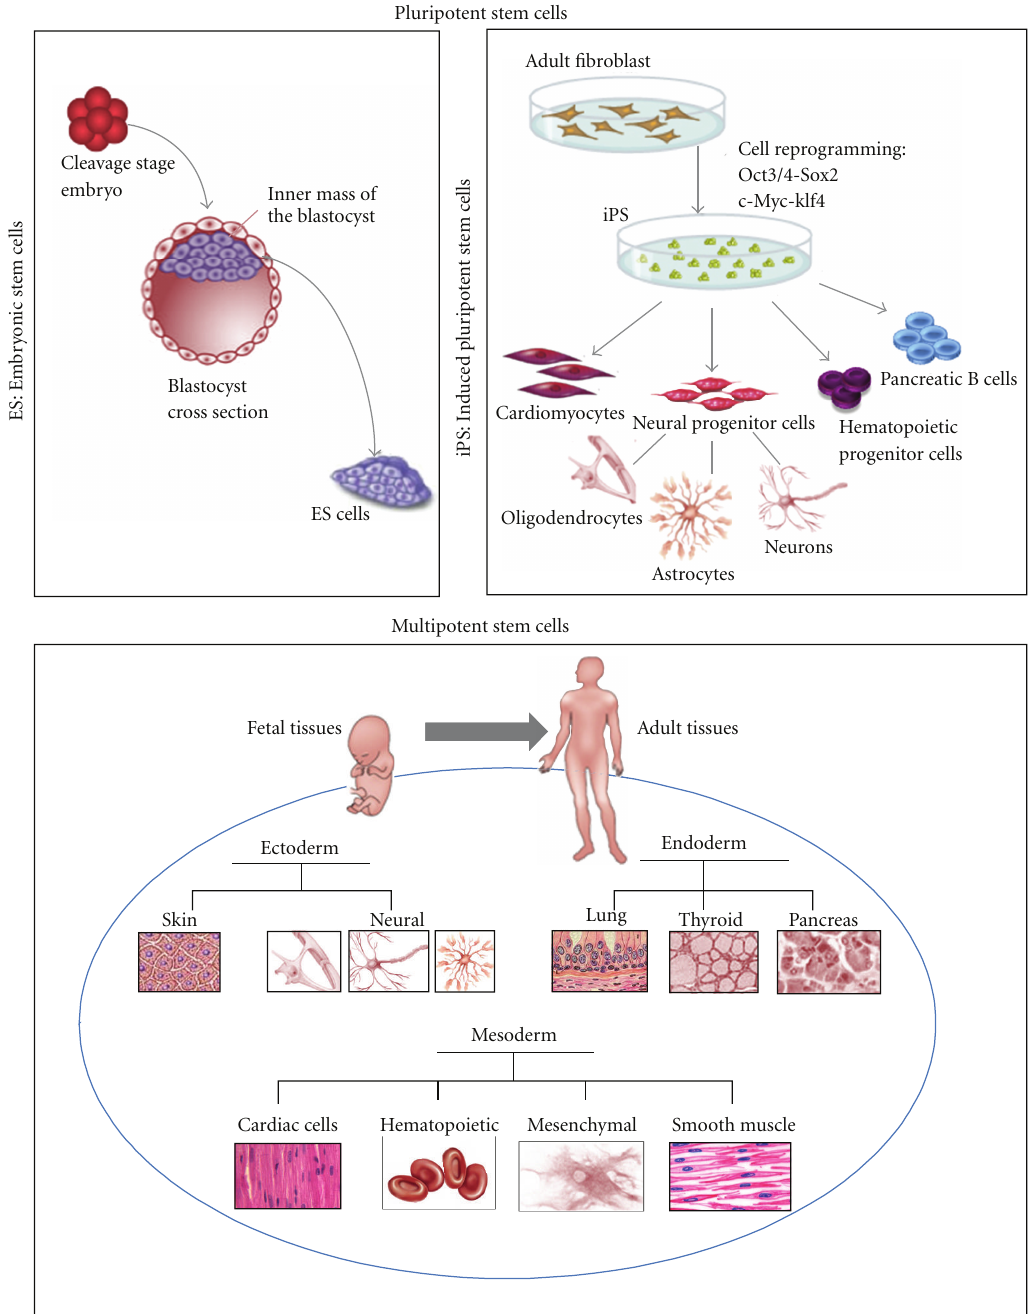
Figure 1: Stem cell type and origin. Beside germ stem cells, three group of stem cells can be defined according to their di ff erentiating abilities: (a) pluripotent embryonic stem cells (ES), (b) induced pluripotent stem cells (iPS), and (c) multipotent fetal or adult somatic stem